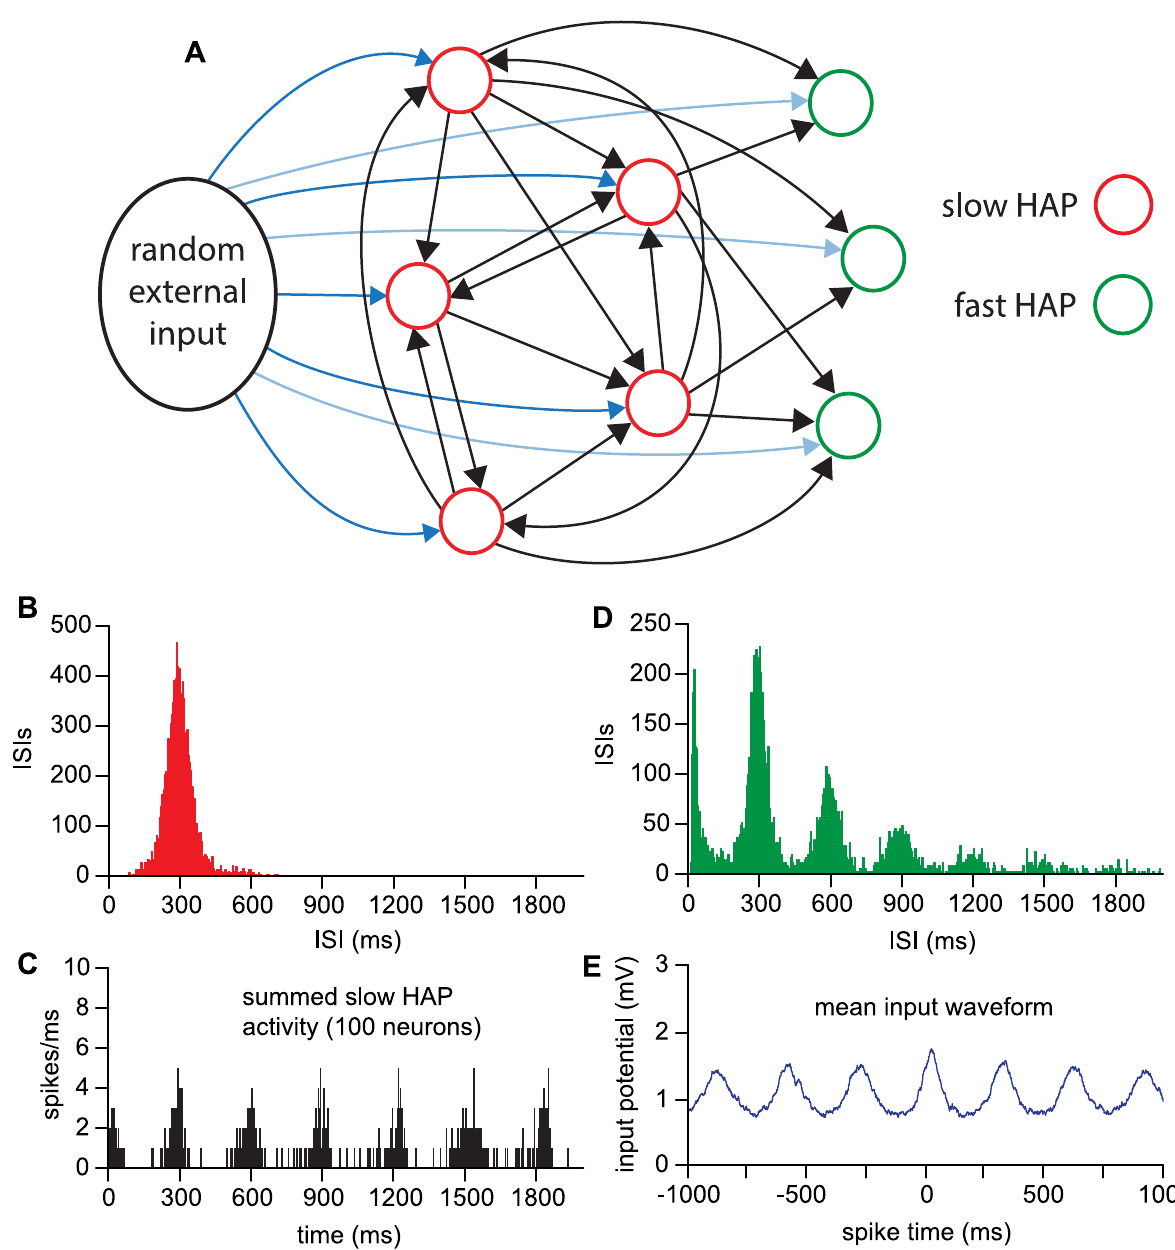
Fig 9. Two cell-type oscillatory network. (A ) A network of 100 slow HAP neurons ( esyn 1 = 0.35) is extended by adding receiving fast HAP neurons (connection probability from slow HAP neurons esyn = 0.2), which also receive their own random external input. ( B) The slow HAP neurons 12 synchronise to generate a 3 Hz rhythmic signal; these neurons each now show a unimodal symmetrical ISI distribution with a mode corresponding to the frequency of the generated rhythm. These distributions are very like those of “regular” VMN neurons. ( C ) The summed activity of the slow HAP neurons shows that the activity of these neurons in the network is approximately synchronous. Synchrony is deliberately reduced by increasing the random element of the transmission delay ( synrange ) to produce more oscillatory summed activity. (D ) The fast HAP neurons that receive this rhythmic input, combined with a random external input, display multimodal ISI distributions very like those of “oscillatory” neurons in the VMN. (E ) The mean input waveform shows the mean model voltage over all spikes (at time 0) in a single fast HAP neuron, closely matching the mean waveform analysis applied to in vivo “oscillatory” neuron data in Fig 8A2 of [20] that showed a subthreshold 3 Hz